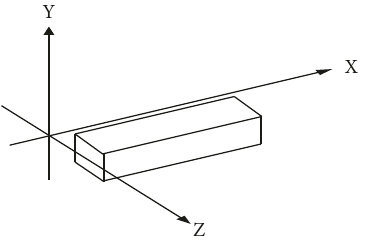
Figure 1: The Link8 space rod